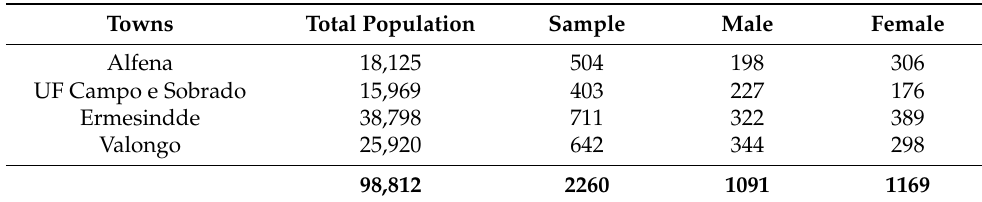
Table 1. Characterisations of the